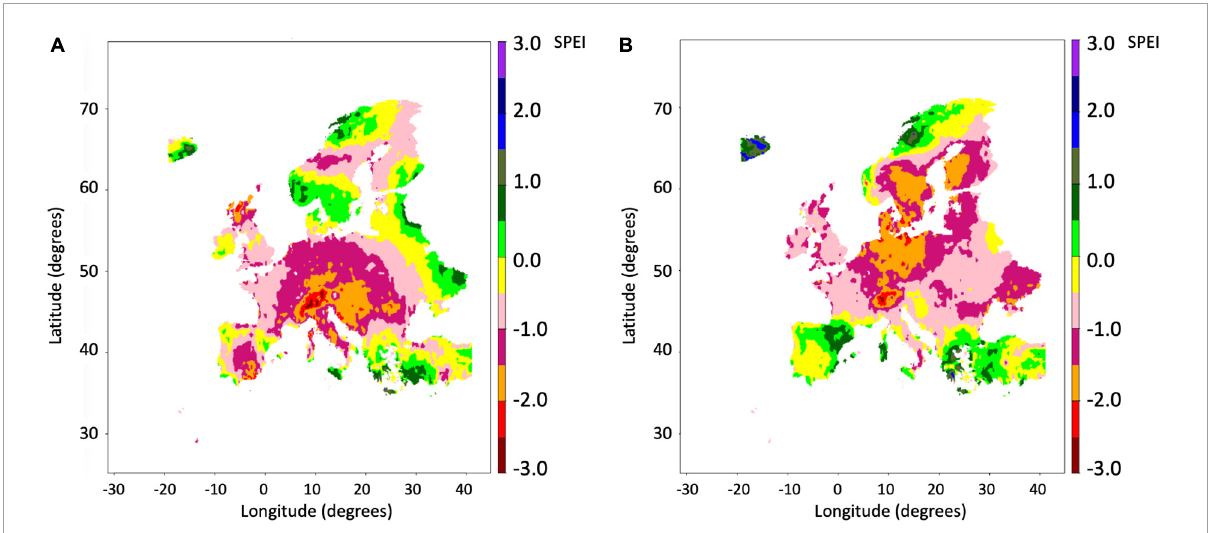
FIGURE2 The Standardised Precipitation and Evapotranspiration Index (SPEI) drought index across Europe based on the 6-month period April–September in (A) 2003, and (B) 2018; using CRU-TS climate data (Harris et al., 2020) downscaled to 12 km resolution. SPEI +3, extremely wet/SPEI –3, extremely